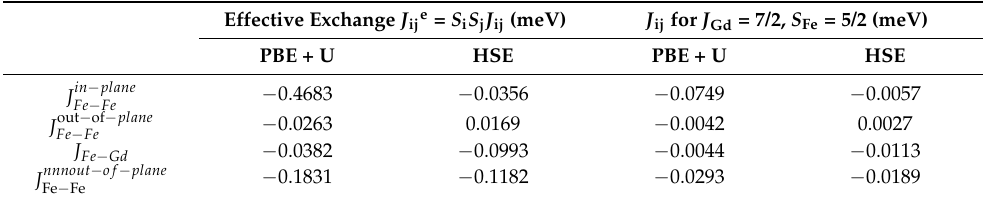
Table 2. Effective and renormalized (with J Gd = 7/2, S Fe = 5/2) exchange constants (meV) obtained by fitting to the PBE + U ( U Gd = 2.09, U Fe = 5 eV) and HSE